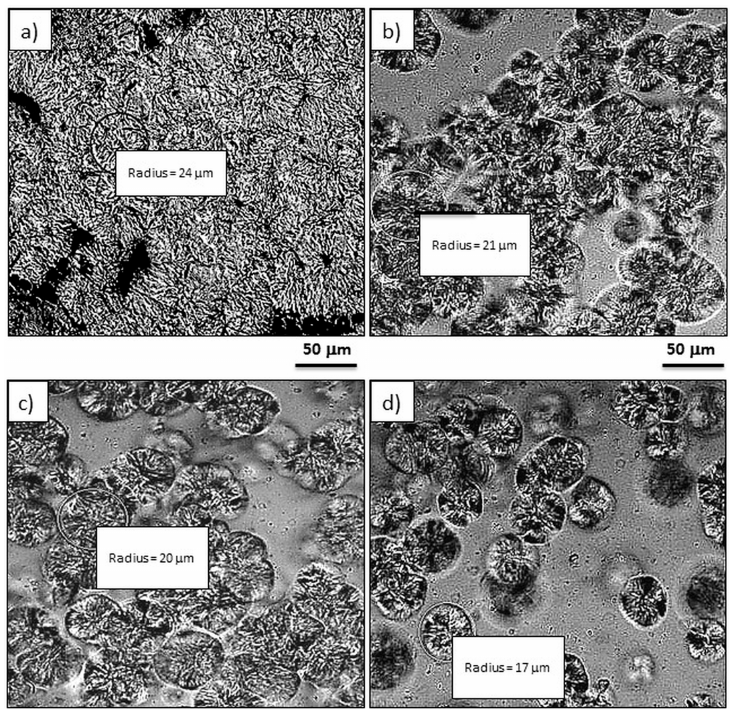
Figure 4. PLM micrographs of the crystallized pure POM ( a ) and its composites with different GPOSS concentrations: ( b ) 0.05 wt. %; ( c ) 0.1 wt. %; ( d ) 0.25 wt. %. T = 148 °C. The cooling rate was set to 20 °C/min. (magnification 200×).